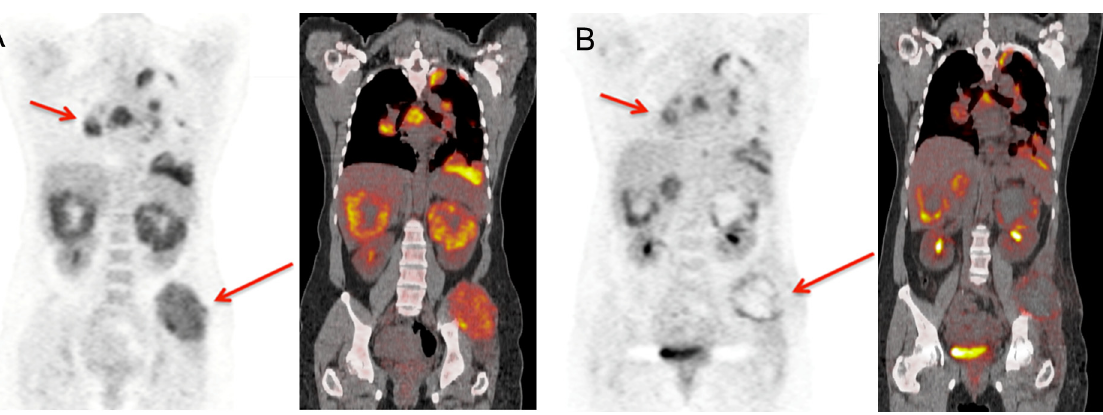
Fig 2. Baseline and post-cycle 2 FDG PET/CT demonstrates improved metabolic activity through multiple bulky foci at the interim therapy scan (red arrows). Size measurements on post-cycle 2 MRI (not shown) had also depicted overall lesion shrinkage. However, patient experienced early progression at 6